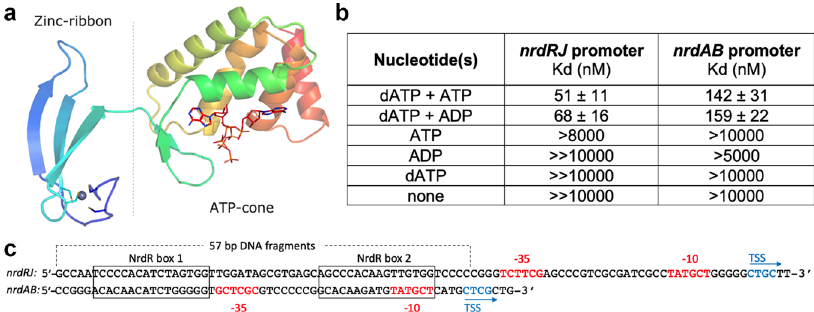
Fig. 1 Structure and binding af fi nity of NrdR. a Structure of the ATP-loaded NrdR monomer (chain A) colored as a rainbow from dark blue at the N-terminus to red at the C-terminus. The probable position of the Zn is indicated with a gray sphere. b Binding constants of NrdR to nrdRJ and nrdAB promoter regions determined by microscale thermophoresis (MST) as shown in Supplementary Figs. 2 and 3. K D s between 10 and 19 µ M are denoted >10 µ M, and above 19 µ M as ≫ 10 µ M. c Promoter regions of nrdRJ and nrdAB with NrdR boxes, RNA polymerase binding sites (red), transcription start sites (blue; from Borovok et al. 2004 (ref. 13 )), and 57 bp DNA fragments used in MST analyses